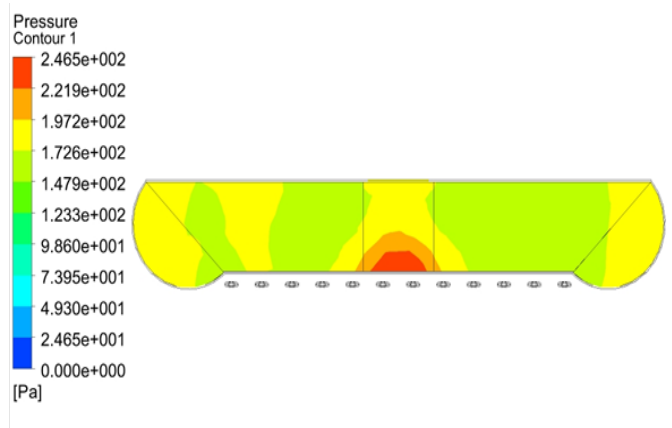
Figure 6. Pressure contour at YZ plane of